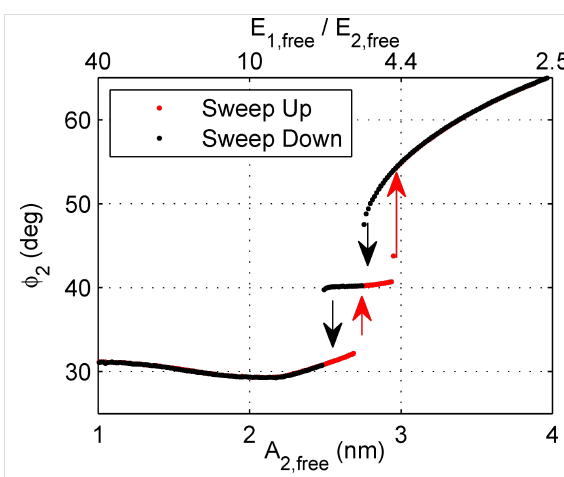
Figure 5: A simulation in which the second eigenmode drive ampli- tude is swept up and then down continuously. The feedback controller remains active so that a constant setpoint is maintained (i.e., A 1 is constant). The parameters are given in Table 2. The lower x -axis shows the second eigenmode amplitude and the upper x -axis the ratio of the first and second eigenmode energies (both quantities calculated based on the free case). Interestingly, there are two discrete jumps in the second eigenmode response indicating that there are three distinct dynamic states. Further, the jumps do not occur at the same ampli- tude on sweep up versus sweep down, indicating that the states are bistable.